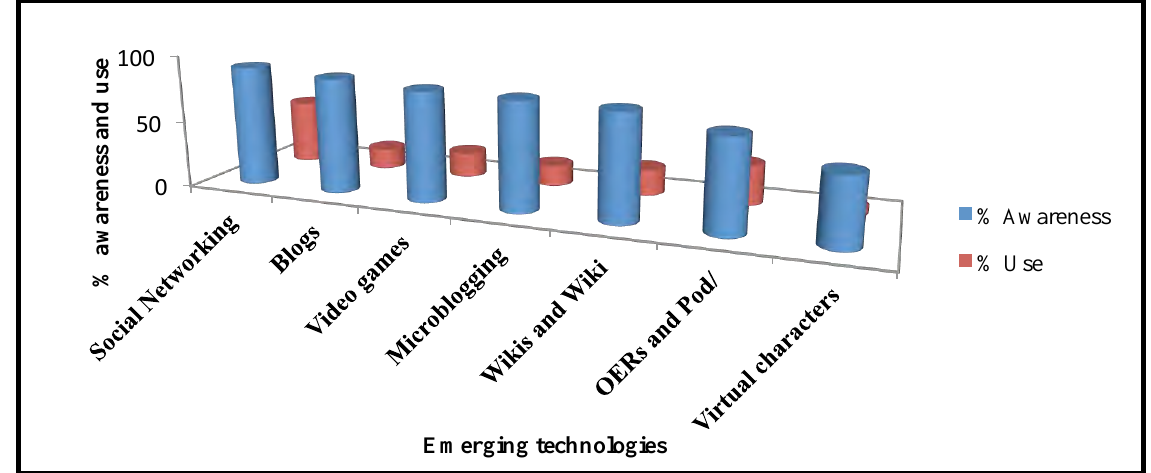
Figure 4 : Awareness and